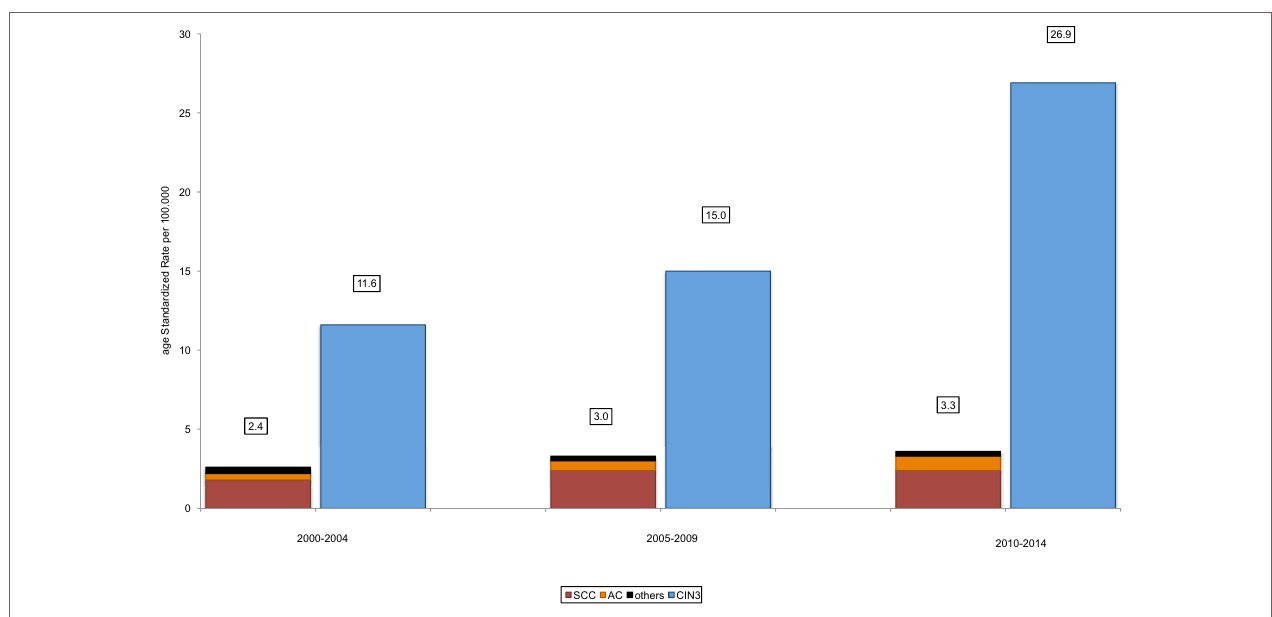
FigUre 3 | Trends in age-standardized incidence of cervical cancer (CC) and CIN3 in conizations in Central Switzerland, 2000–2014. There is a trend toward increasing age-standardized incidence rates (ASIR) of CC ( p -value 0.075) and a significant increase of ASIR of CIN3 ( p -value < 0.001). There is no significant increase of ASIR of squamous cell carcinoma (SCC) from 1.8/100,000 between 2000 and 2004 to 2.4/100,000 between 2005 and 2009 and between 2010 and 2014 ( p -value 0.132) and of adenocarcinoma (AC) from 0.4/100,000 between 2000 and 2004 to 0.6/100,000 between 2005 and 2009 to 0.9/100,000 between 2010 and 2014 ( p -value